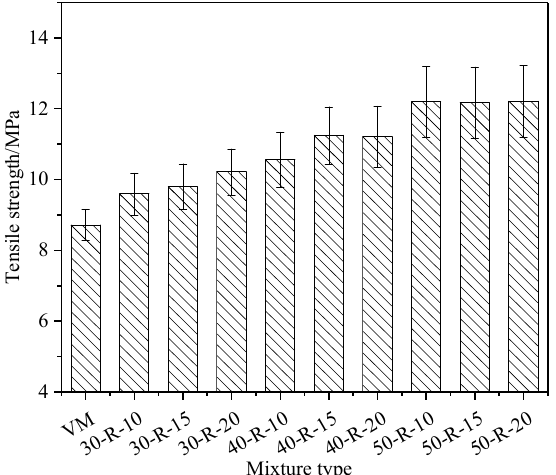
Figure 3. The tensile strength of mixtures with different reclaimed asphalt pavement (RAP) and fine reclaimed asphalt pavement (FRAP) contents.